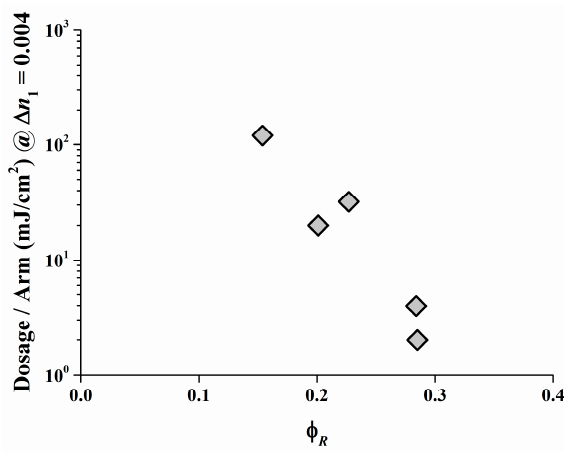
Figure 10. Dosage per arm necessary to obtain a ∆ n 1 = 0.004 as a function of φ R [35].